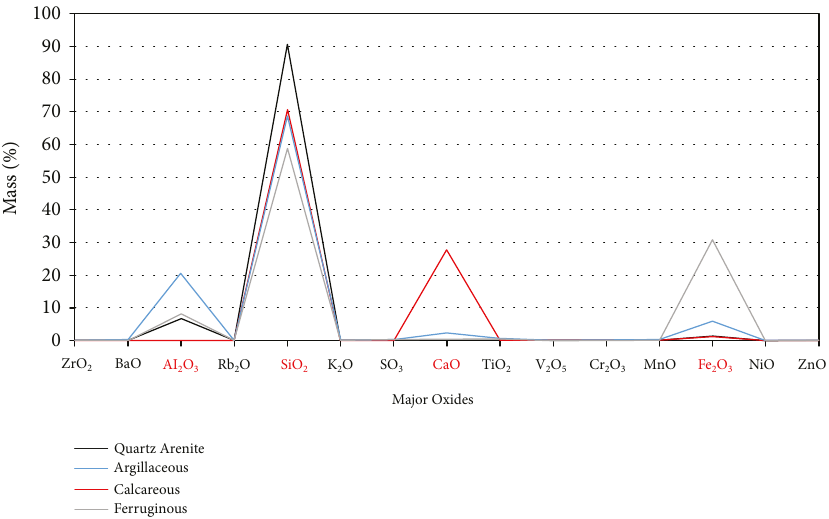
Figure 3: XRF results of the drilled cuttings (core